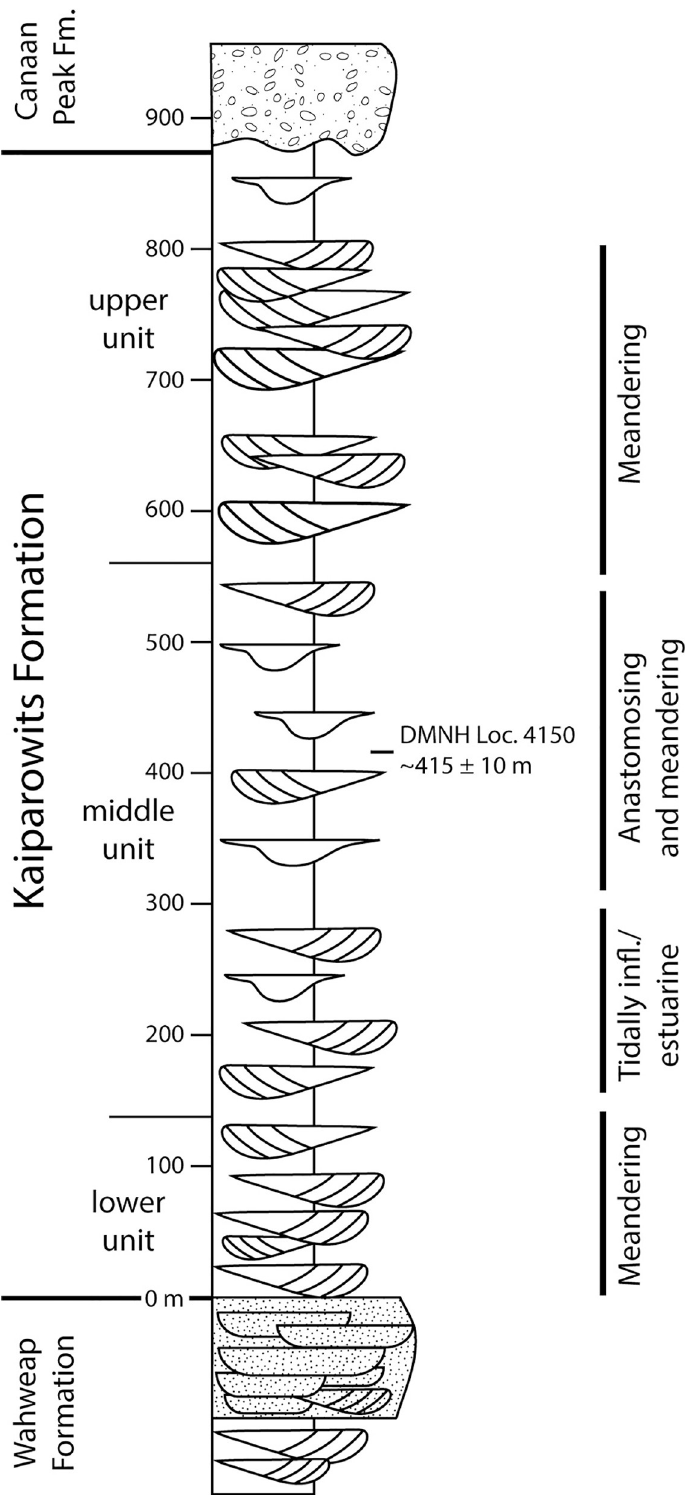
Fig 2. Representative stratigraphic column for the Kaiparowits Formation. Redrawn from Roberts [29] showing major sedimentary modes. The stratigraphic position of DMNH loc. 4150, where the type and referred material for Catula gettyi was collected, was located by directly measuring section from the contact with the Wahweap Formation with the assistance of J. Hagadorn and M. Marshall in 2015.